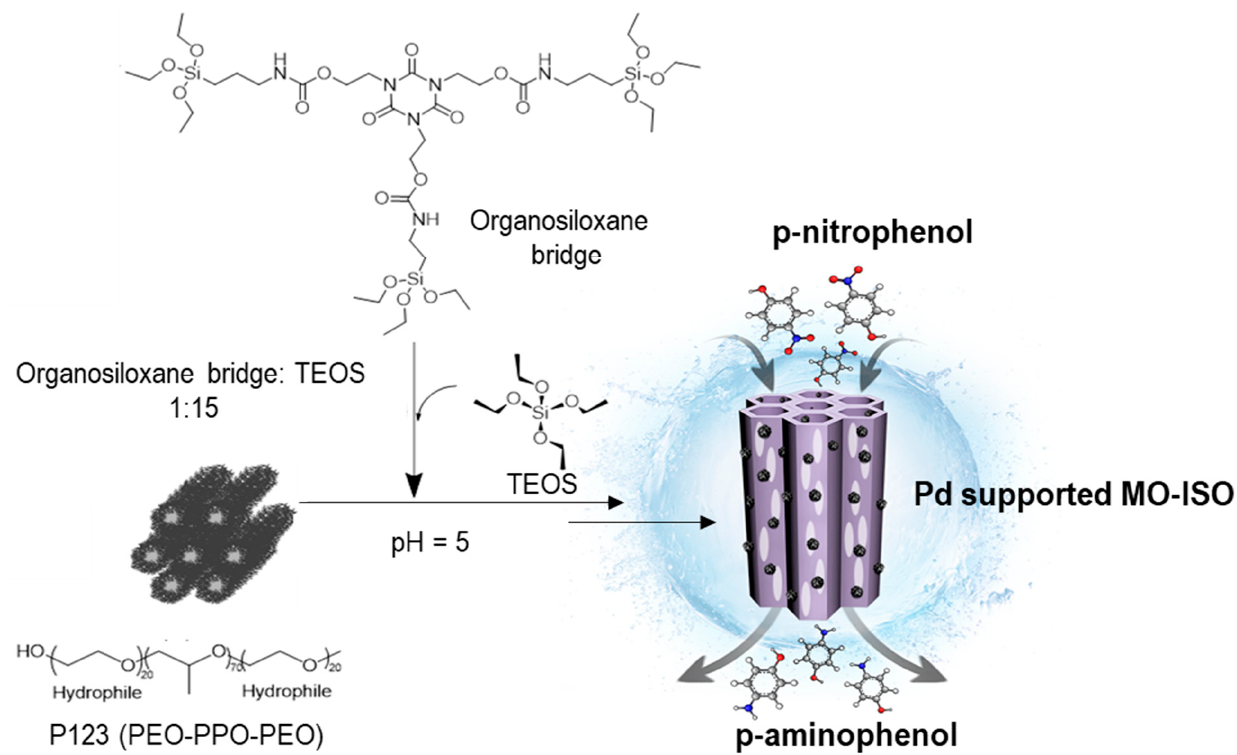
Figure 1. Schematic representation of Pd@MO-ISO synthesis.